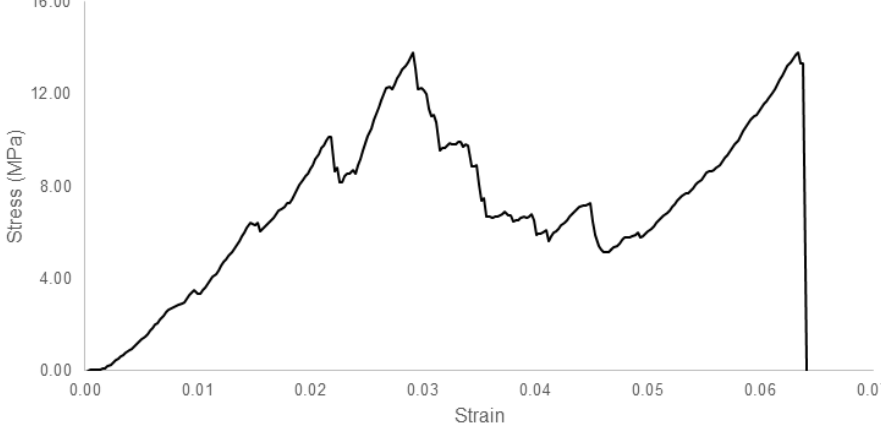
Figure 6. Typical stress – strain curve (compressive test) of 1d-derived